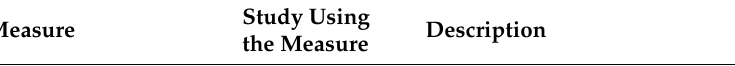
Table 1. Description of